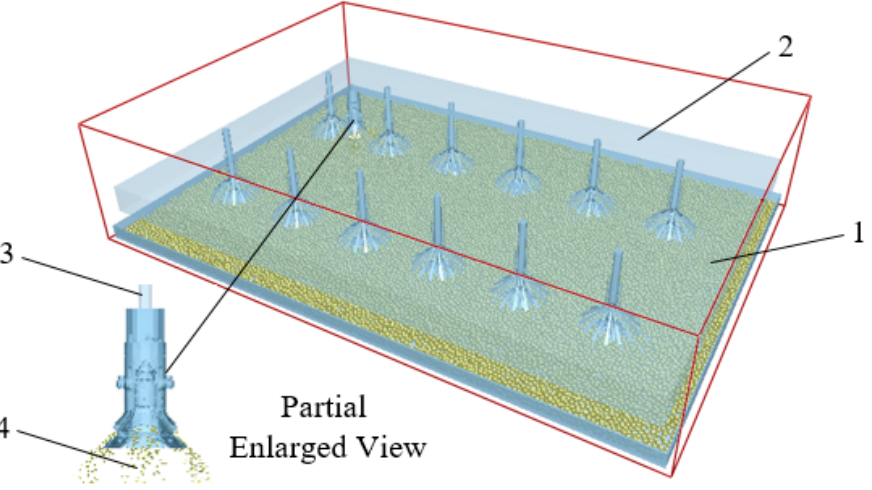
Figure 6. Simulation process. 1. Soil particles, 2. soil particles factory, 3. fertilizer particles factory, 4. fertilizer particles.